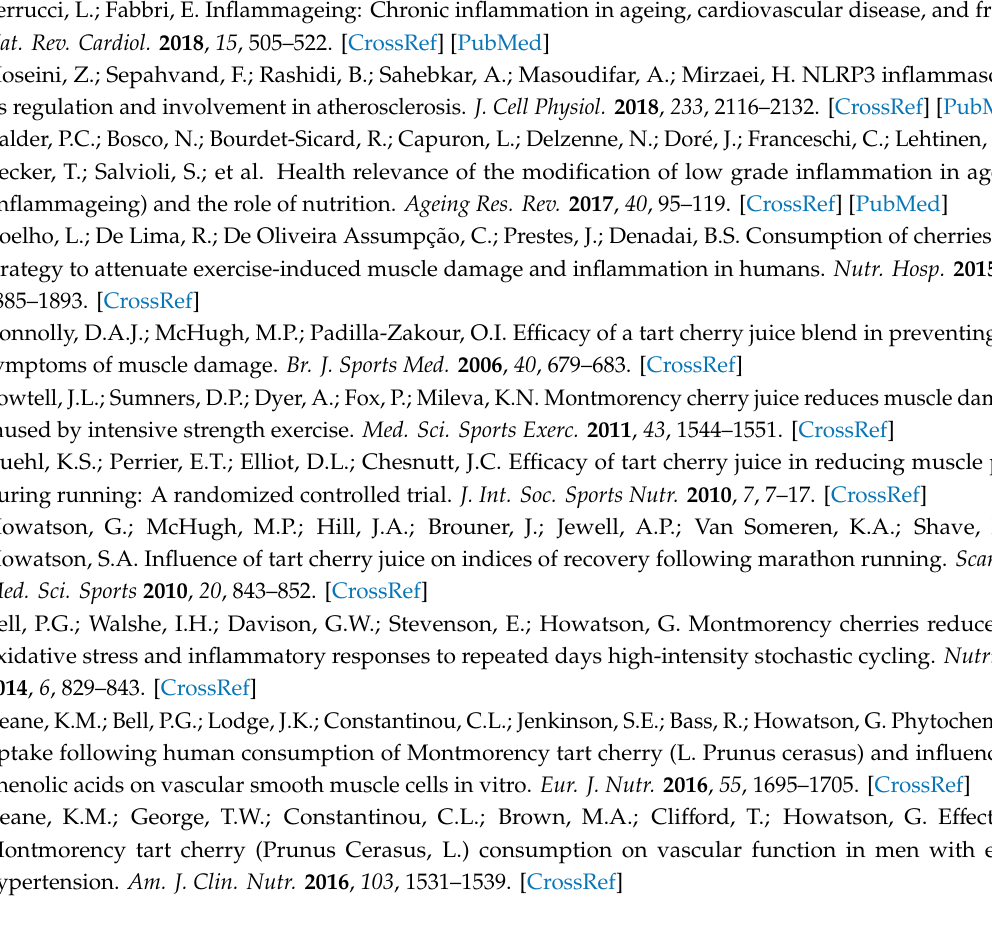
Figure S1: CLSM analysis of C2BBe1 incubated with FITC-labeled QA-Ch, QA-Ch-S-pro, or PLGA NPs for 1 h (A) or 2 h (B); Figure S2: Fluorescent images of FITC-labeled NP internalization by C2BBe1 after 1 h or 2 h treatment (A), NP internalization score (B), and fluorescence intensity (B) histograms, obtained by ImageStream ® X imaging flow cytometer; Table S1: Statistical analysis of Figure S1B,C, provided by IDEAS ® Software; Figure S3: FACS analysis before (A,C) and after (B,D) fluorescence quenching with trypan